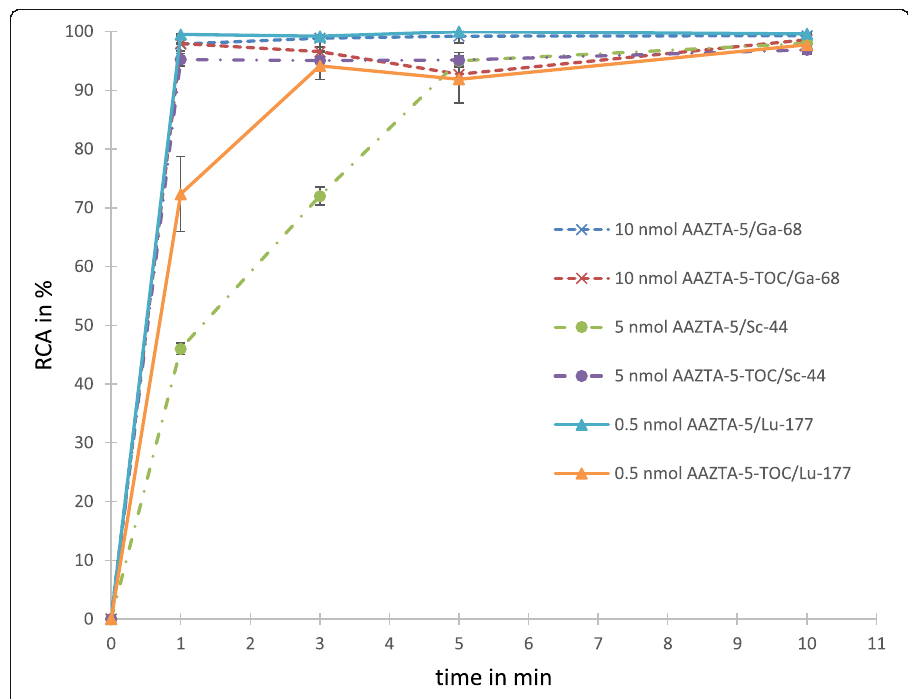
Fig. 2 Labelling kinetics for lowest precursor amounts to reach reproducible quantitative yields within 10 min at room